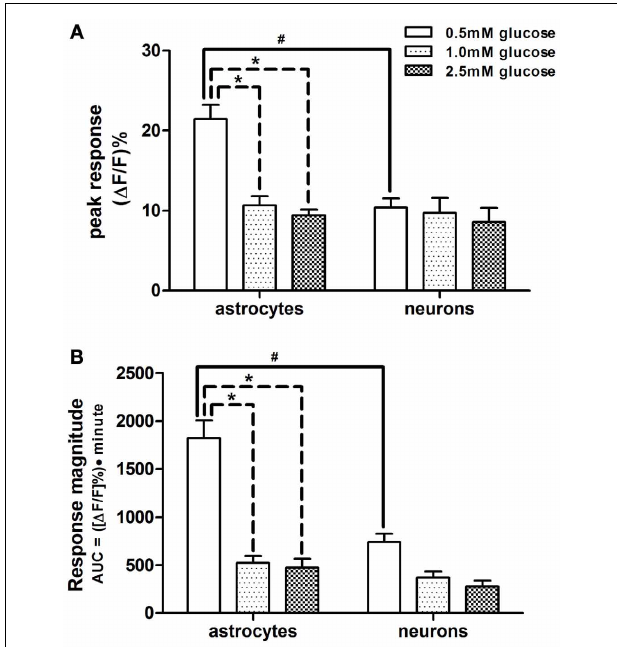
FIGURE 3 | Comparison of response parameters of NST-astrocytes and -neurons to low glucose conditions. Subsets of both astrocytes and neurons responded with increased activation, as seen by their change in fluorescence, when exposed to lower glucose concentrations in the perfusion solution. Two-Way ANOVA of the peak and magnitude of astrocytic and neuronal responses to low glucose conditions revealed that astrocytes were more responsive than neurons in (A) peak response and (B) response magnitude, i.e., area under the curve [significant main effect of cell type; F ( 1 , 159 ) = 8 . 36 and 12.57, respectively; p < 0 . 05]. There were significant main effects attributed to the concentration of glucose [ F ( 2 , 159 ) = 8 . 40 and 18.57; respectively; p < 0 . 05]. These main effects are qualified due to the significant interactions between cell types and glucose concentrations [ F ( 2 , 159 ) = 5 . 24 and 4.99, respectively; p < 0 . 05]. Bonferroni post-hoc t -tests demonstrated that astrocytes and neurons differ significantly in these response parameters when 0.5mM glucose was in the perfusion bath; # p < 0 . 05. In astrocytes, these response parameters at the 0.5mM glucose level where significantly different from those at the 1.0 and 2.5mM glucose levels; ∗ p < 0 . 05.